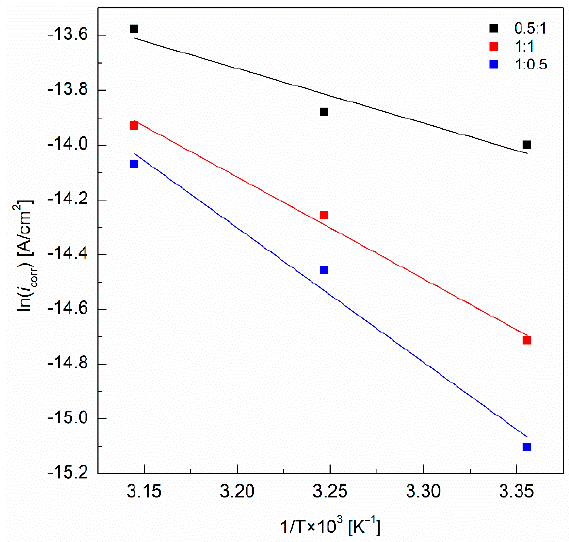
Figure 5. Arrhenius plots for the corrosion inhibitor mixtures of 0.5:1, 1:1, and 1:0.5 NaNO 2 :NO 3 in 0.6 M NaCl.